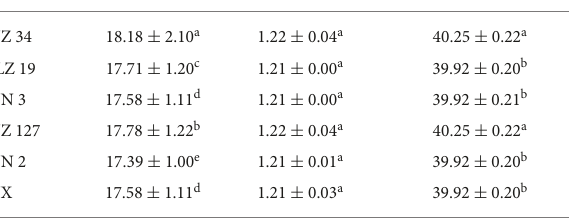
TABLE 2 Micrometric properties of sorghum